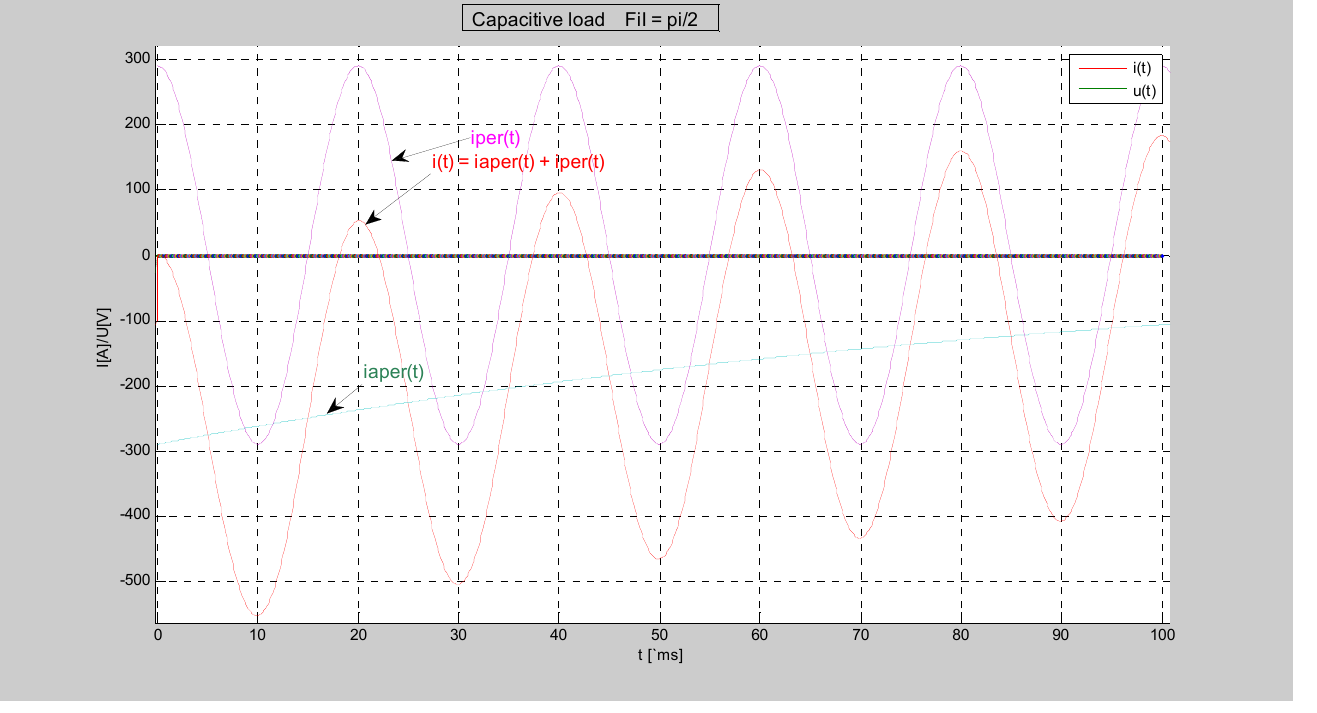
Figure 10. Characteristic transient current capacitive load.